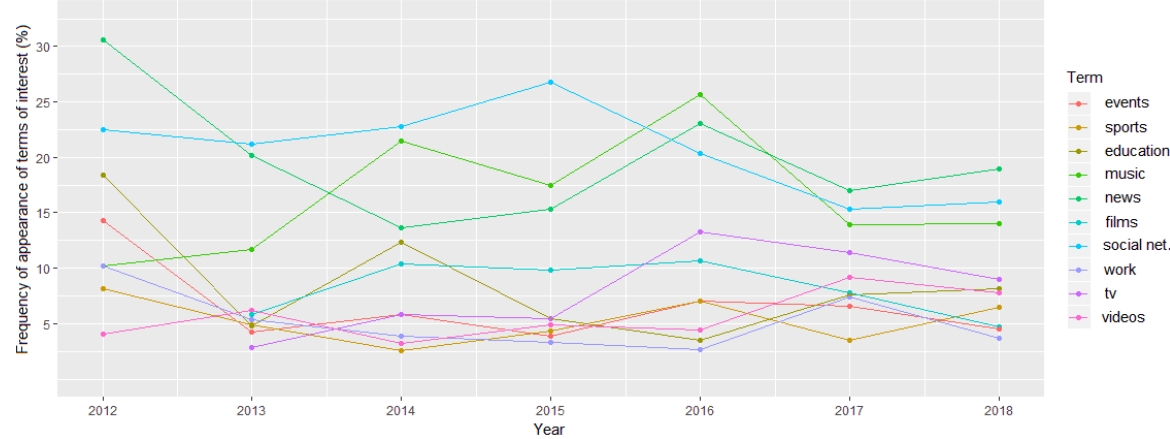
Figure 3. Annual variation of the 10 most common terms named by respondents as topics of interest for web surfing.